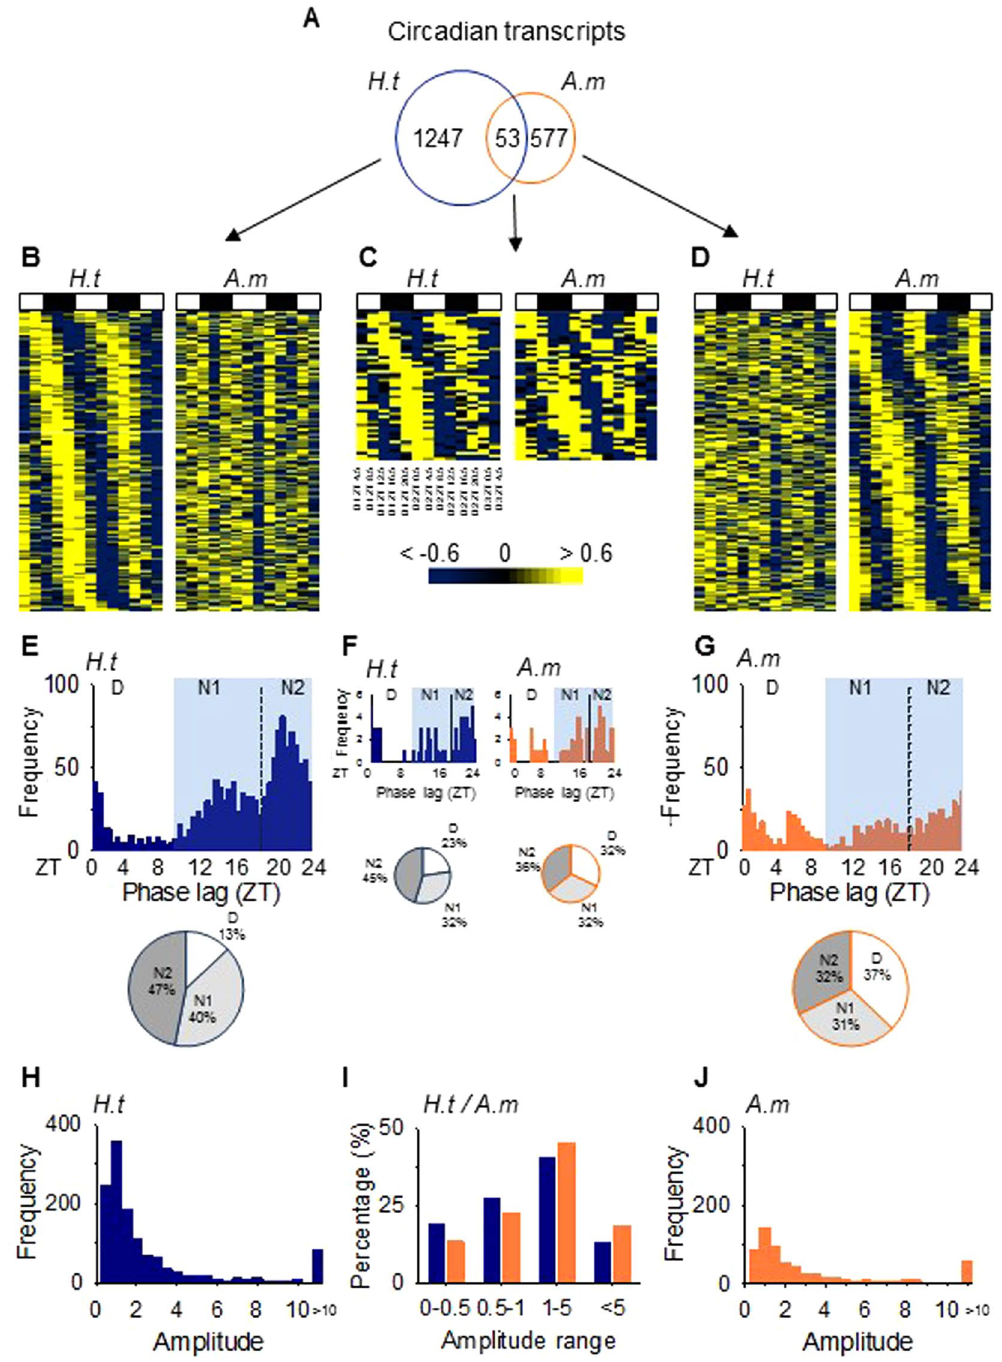
Figure 1. A circadian transcriptome with a nocturnal pattern remodeled with A. minutum exposure. ( A ) The number of circadian transcripts. ( B – D ) Heat maps of expression organized by phase for the 300 most significant transcripts oscillating only in H.t ( B ), common in both ( C ) and only in A.m ( D ). ( E – G ) Phase lag, i.e., peak of expression along the cycle, distributions (frequency in number of transcripts) and corresponding pie charts for all oscillating genes in H.t ( E ), A.m ( G ) and both ( F ). “D”: phase lag distribution during the day (ZT0-ZT9). “N1” (ZT9-ZT19) and “N2” (ZT19-ZT24): phase lag distribution during the first and second part of the night. ( H – J ) Amplitude distribution (frequency in number of transcripts) for all circadian transcripts in H.t ( H ), A.m ( J ), and both ( I ), classed by amplitude